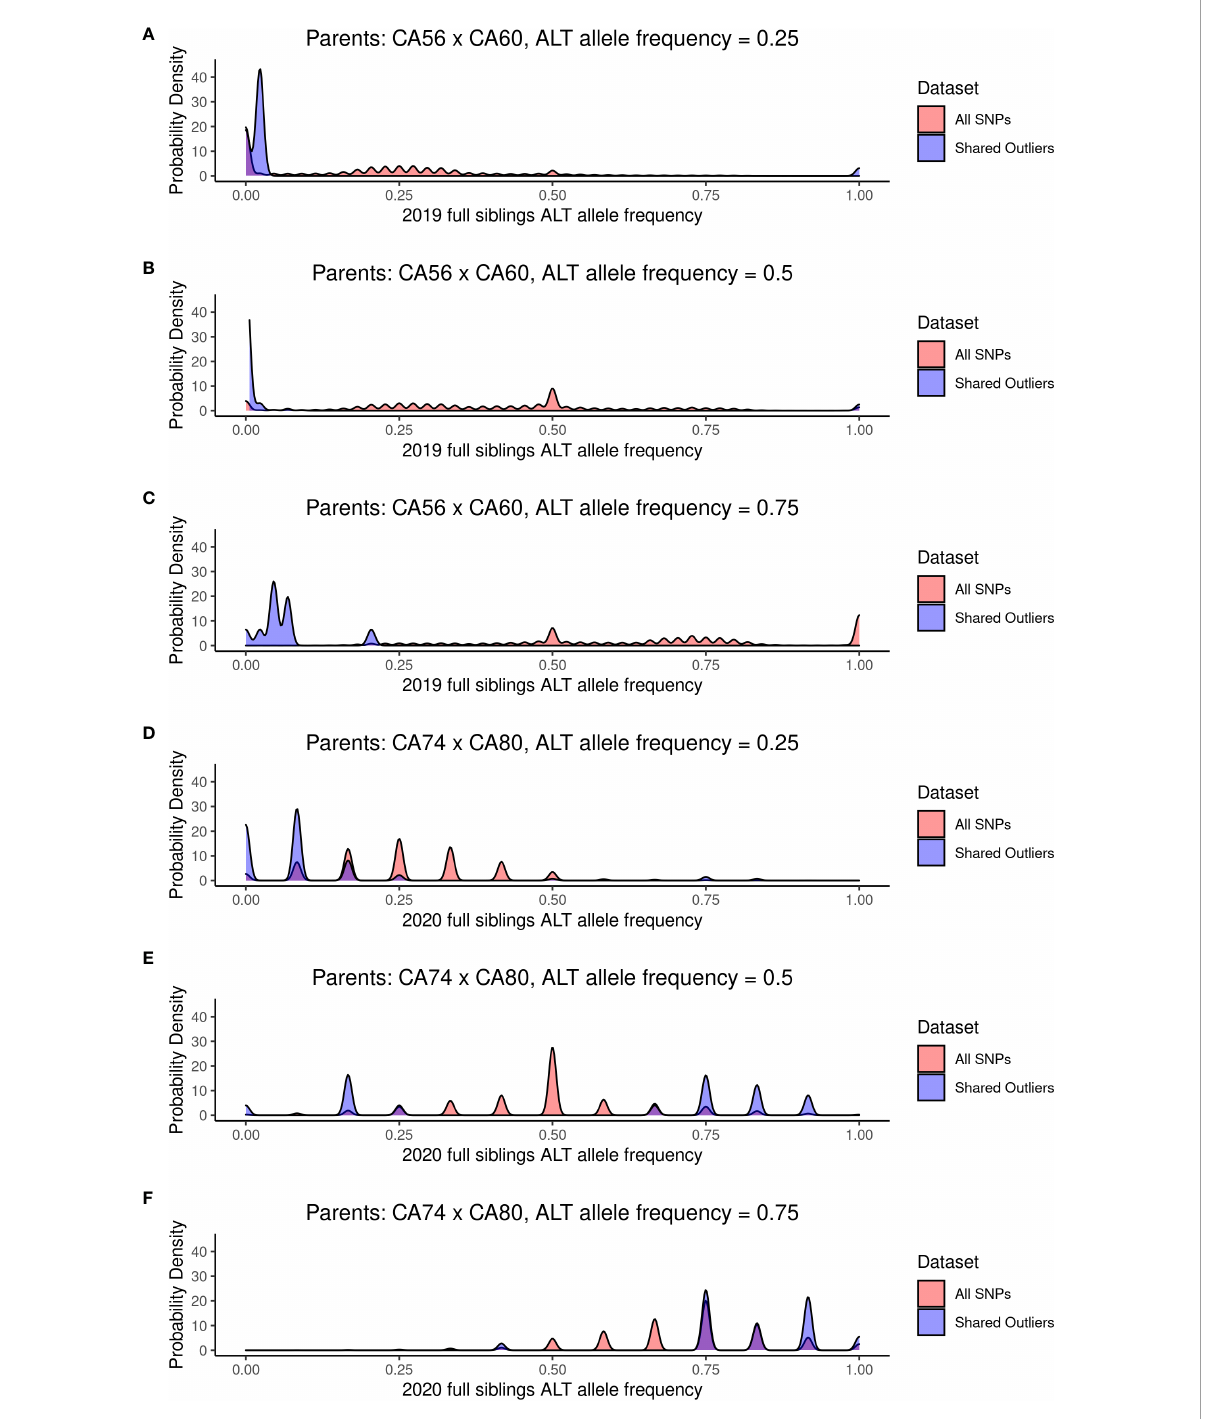
FIGURE 6 The probability density of allele frequencies for the 22 full siblings produced in 2019 (A – C) and the six full siblings produced in 2020 (D – F) . The probability densities are shown for the SNPs where the two parents had alternate allele frequency of 0.25 (A, D) , 0.5 (B, E) , and 0.75 (C, F)